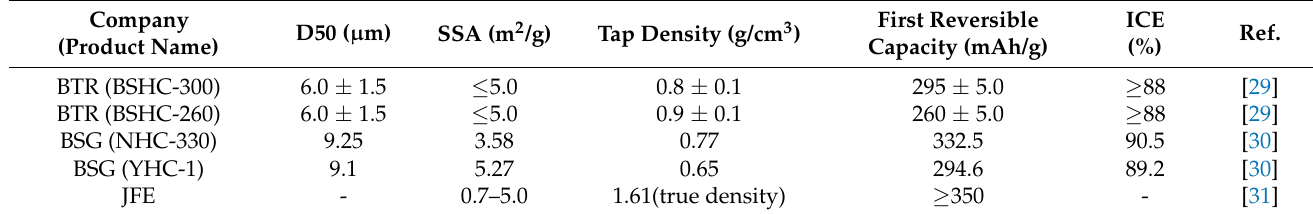
Table 3. Properties of commercial hard carbon